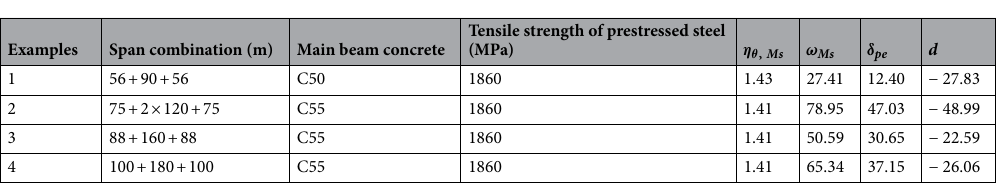
Table 3. Structural parameters of real bridge (mm).